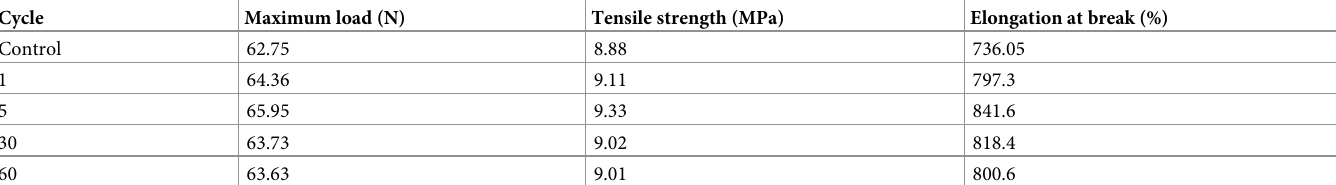
Table 7. Mean tensile strength of the strap before and after dry heating at 75˚C for 5